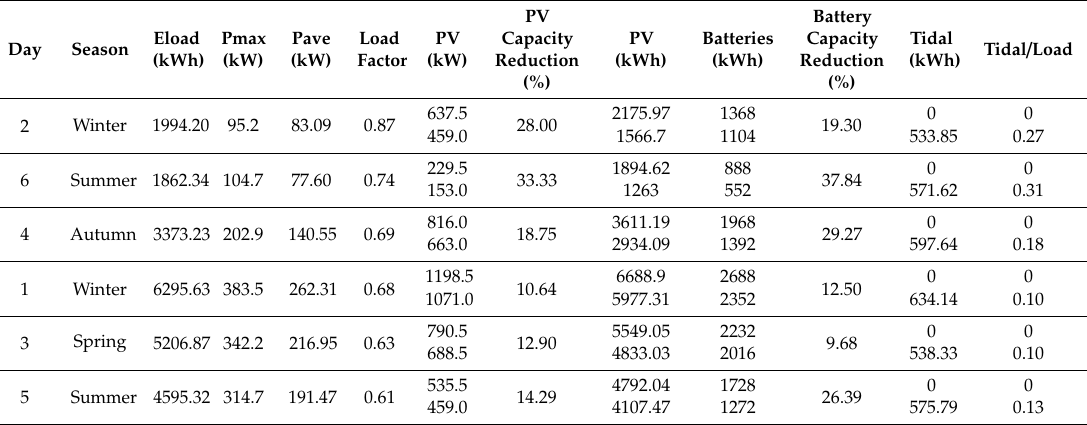
Table 3. Optimum photovoltaic (PV)-battery combination for the 6 load profiles with and without tidal